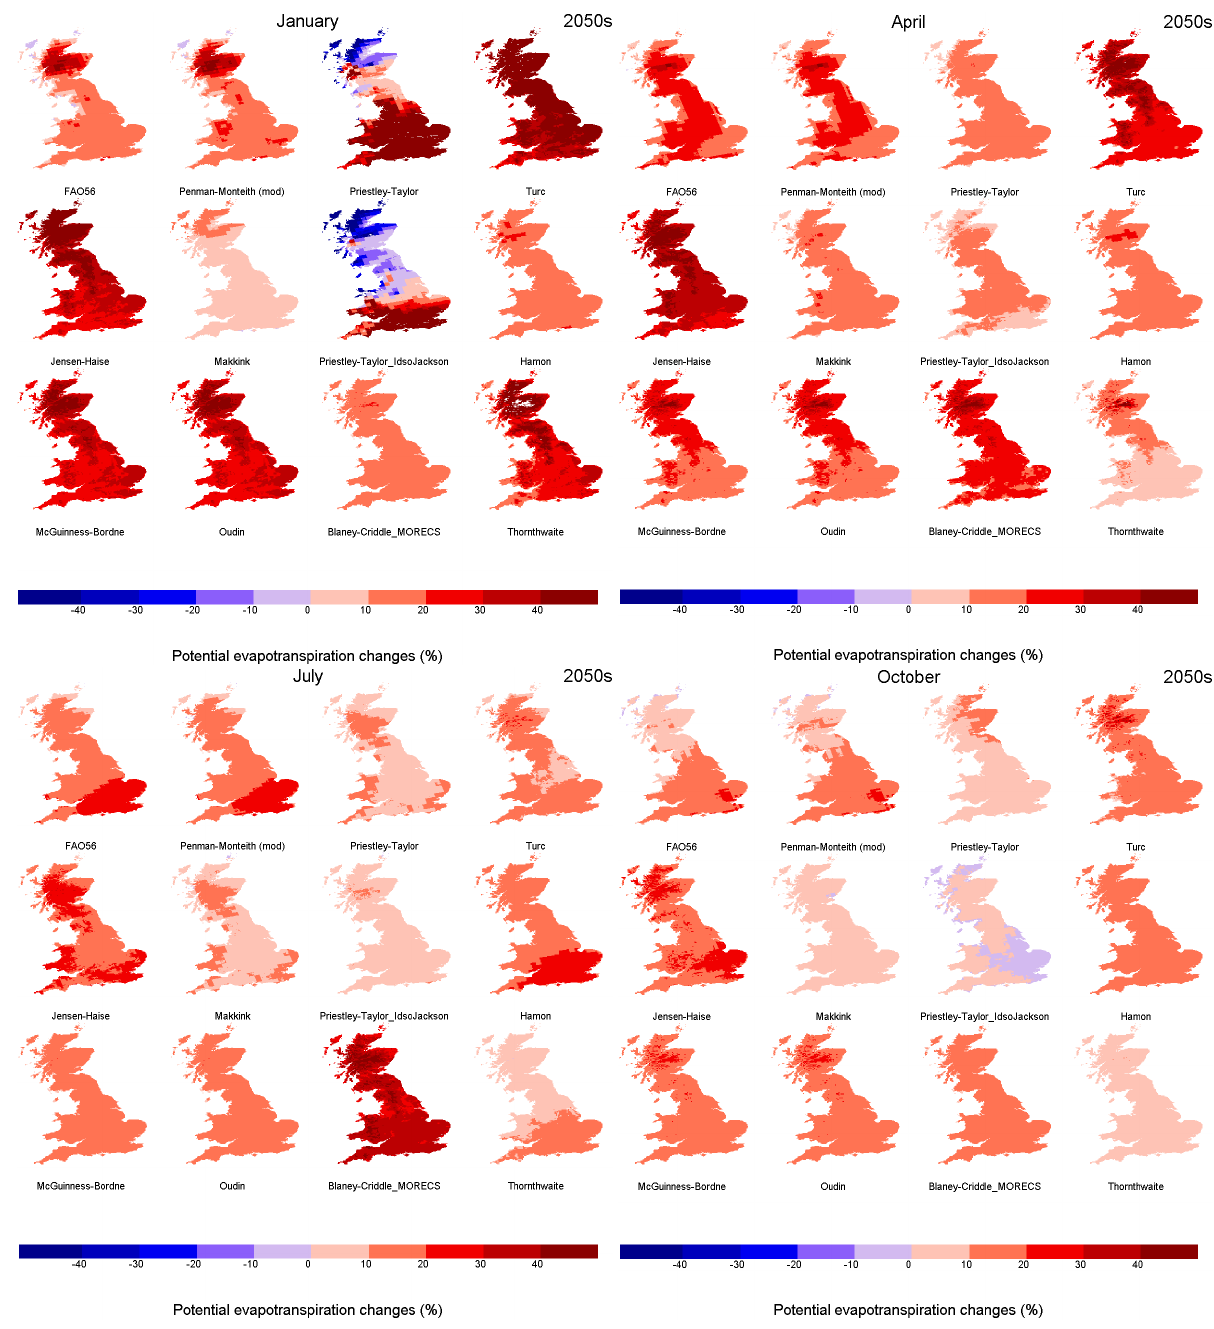
Fig. 3. PET percentage changes between averages values calculated for the 1961–1990 and 2040–2069 time slices for the 12 PET methods and four typical